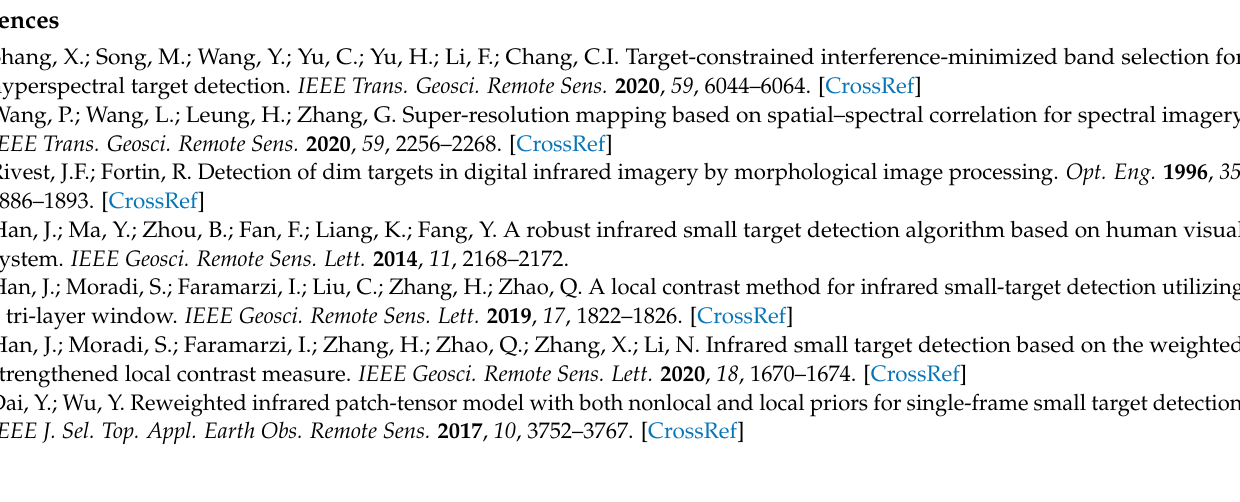
Figure 16. Comparison of ablation study results, where targets are shown in the red circle.